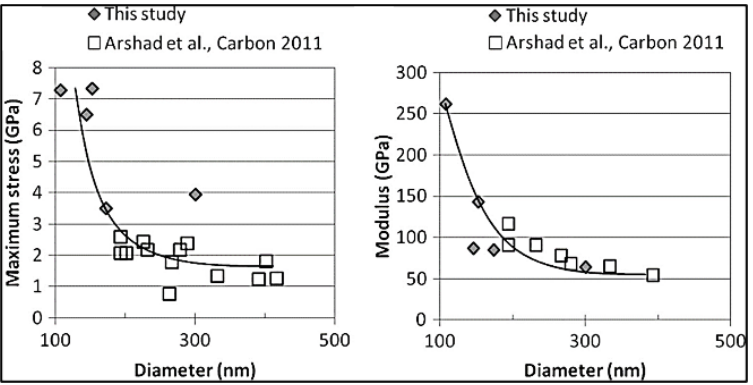
Figure 9. Strength and modulus of individual carbon nanofiber obtained from PAN nanofiber mat [104].